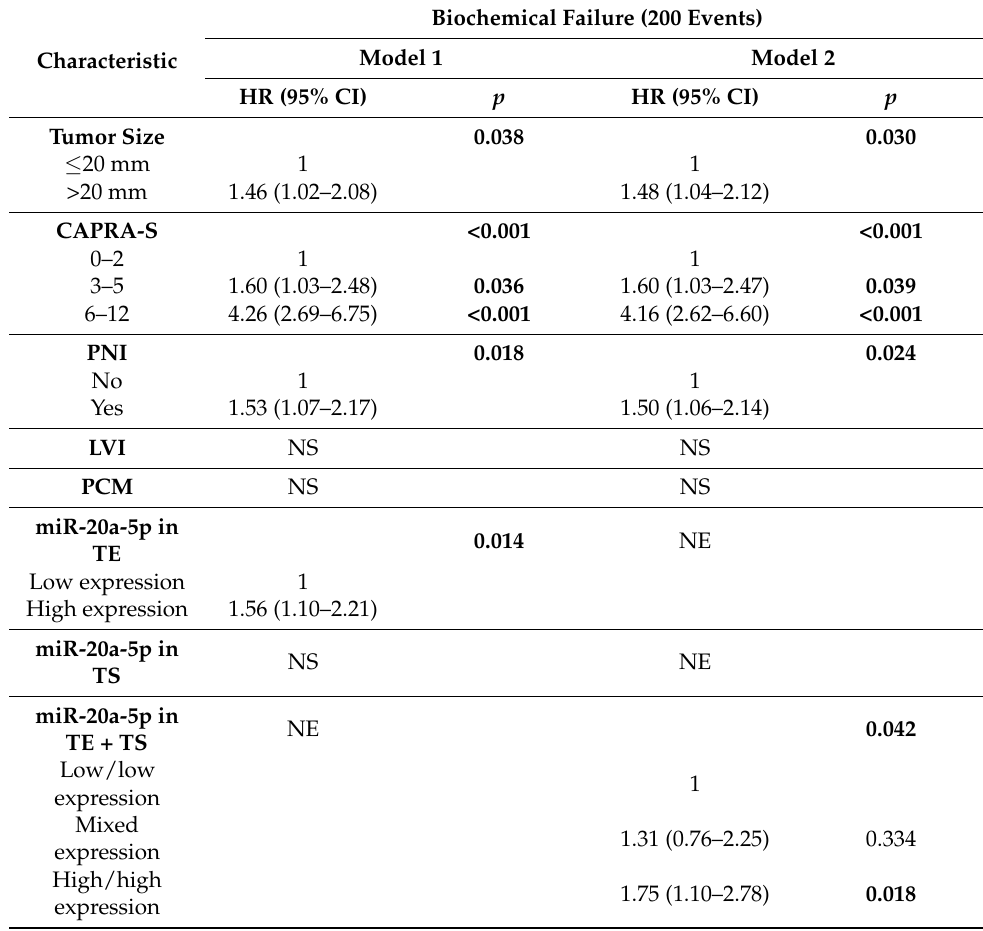
Table 2. Exploring miR-20a-5p impact as independent prognostic variable for BF. Multivariate analysis of miR-20a-5p expression and significant clinicopathological variables from the univariate analyses (Cox regression analyses, n = 535, backward conditional). Univariate analyses are in Table 1 and Supplementary Table S3. p -values below 0.05 marked in bold. Abbreviations: BF = biochemical failure; HR = hazard ratio; LVI = lympho-vascular infiltration; NE = not entered; NS = not signif- icant; p = p -value; PCM = positive circumferent margin; PNI = perineural infiltration; TE = tumor epithelium; TS = tumor